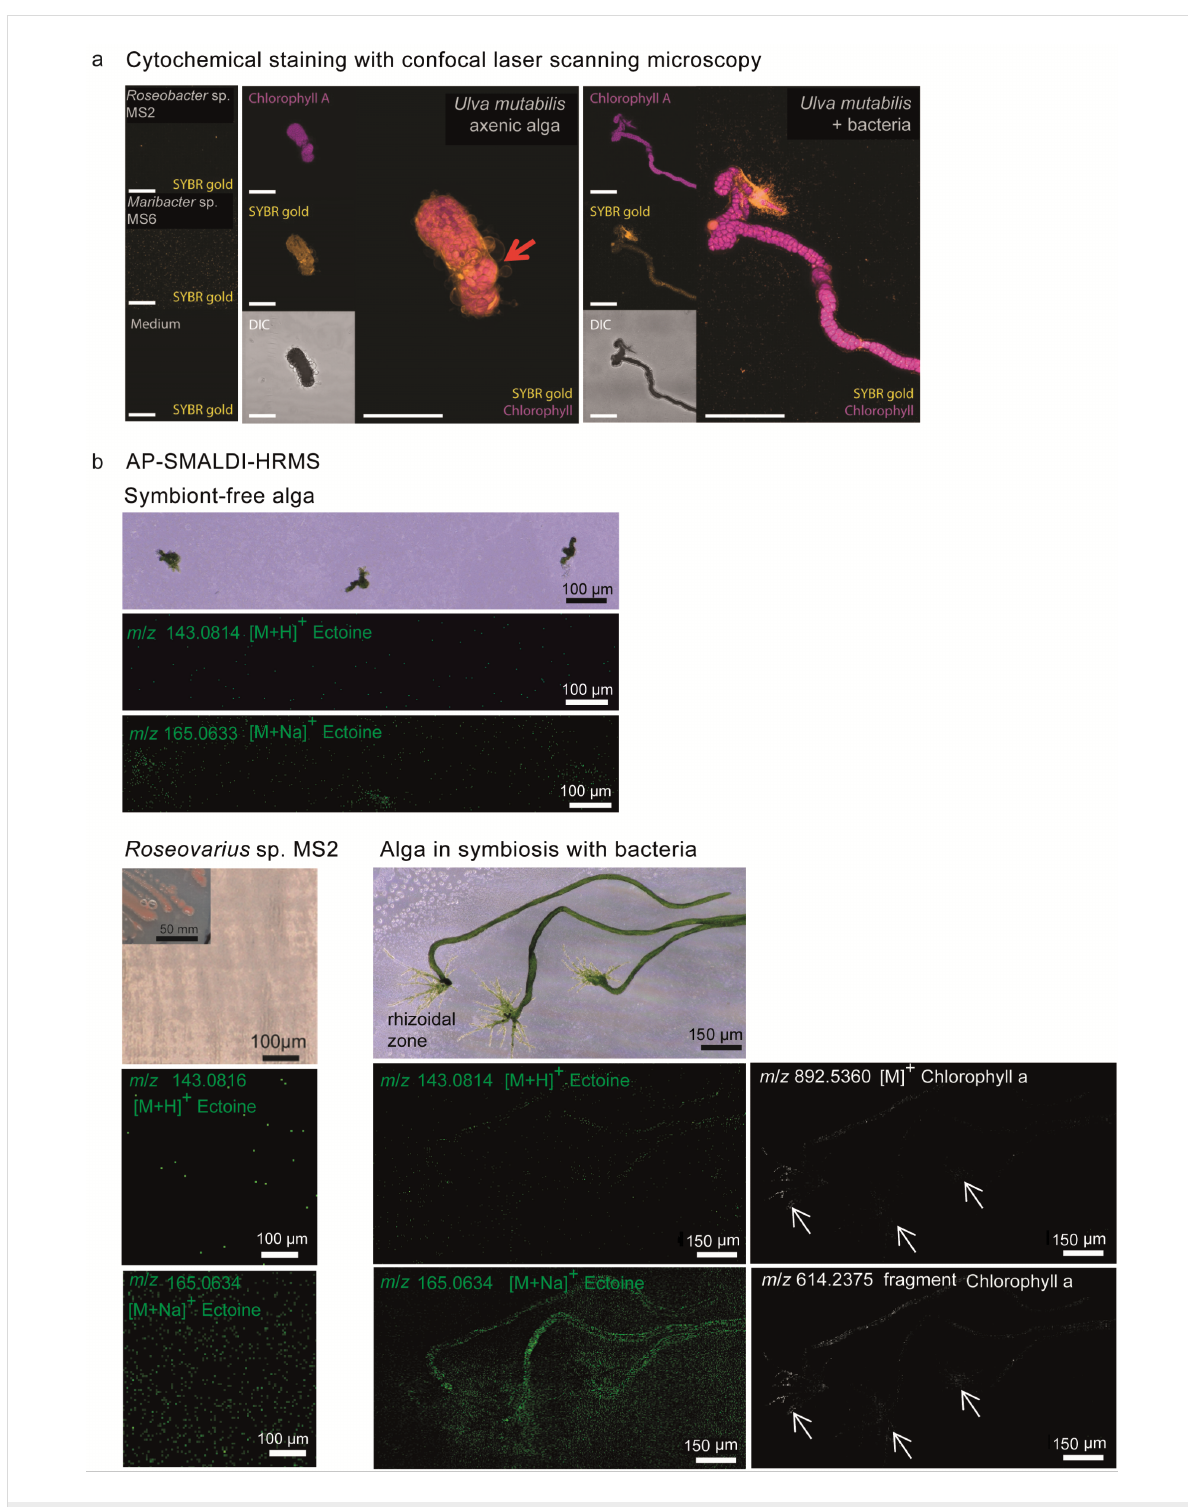
Figure 3: Visualisation of algae Ulva mutabilis grown under axenic conditions or with bacterial symbionts Roseovarius sp. MS2 and Maribacter sp. MS6. a) Images acquired after nucleic acid staining with SYBR gold and with confocal laser scanning microscopy. The protrusion of alga grown with- out bacterial symbiont is highlighted (red arrow). DIC: differential interference microscopy. b) The images show ectoine spatial localisation and thus the presence of Roseovarius sp. ( m / z 143.0814 for [M + H] + , m / z 165.0633 for [M + Na] + , shown in green) as well as chlorophyll ( m / z 892.5360 for [M + H] + , m / z 614.2375 fragment shown in white). These metabolite traces are visible in axenic algae, symbiotic algae, and cell cultures of bacteria Roseovarius sp. MS2. White arrows indicate the rhizoidal